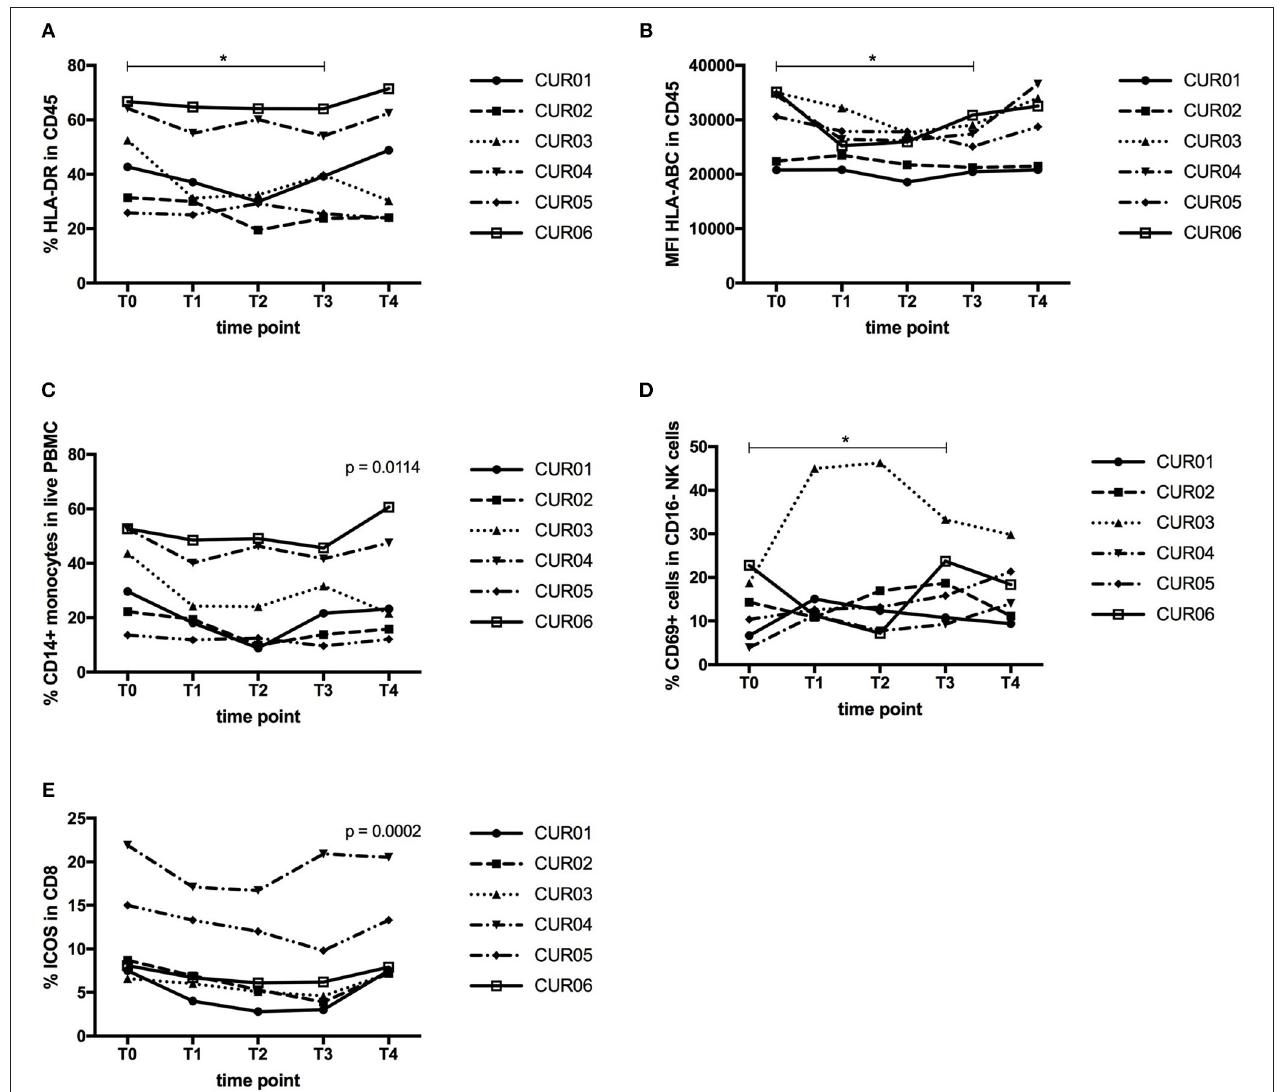
FIGURE 4 | Effect of curcumin supplementation on immunological cell types. (A) Expression of HLA-DR by CD45 + leukocytes determined by flow cytometry, expressed as percentage of HLA-DR expressing CD45 + leukocytes. (B) Expression of HLA-ABC by CD45 + leukocytes determined by flow cytometry, shown as mean fluorescence intensity (MFI) of HLA-ABC expressed by CD45 + leukocytes. (C) Percentage of CD14 + monocytes in the total PBMC population determined by flow cytometry. (D) Percentage of CD69-expressing cells within the CD56 + CD16 − NK cell population measured by flow cytometry. (E) Percentage of ICOS-expressing cells within the CD3 + CD4 − CD8 + T cell population measured by flow cytometry. Each line depicts one patient. Time points are as follows: T0, baseline, T1-day 1 of treatment, T2-day 7 of treatment, T3-day 14 of treatment, T4, 1 week after last CP dose. P values were determined using the Wilcoxon signed rank test (A,B,D) or the one-way repeated measure analysis of variance (ANOVA) test (C,E) with Prism software. * P <